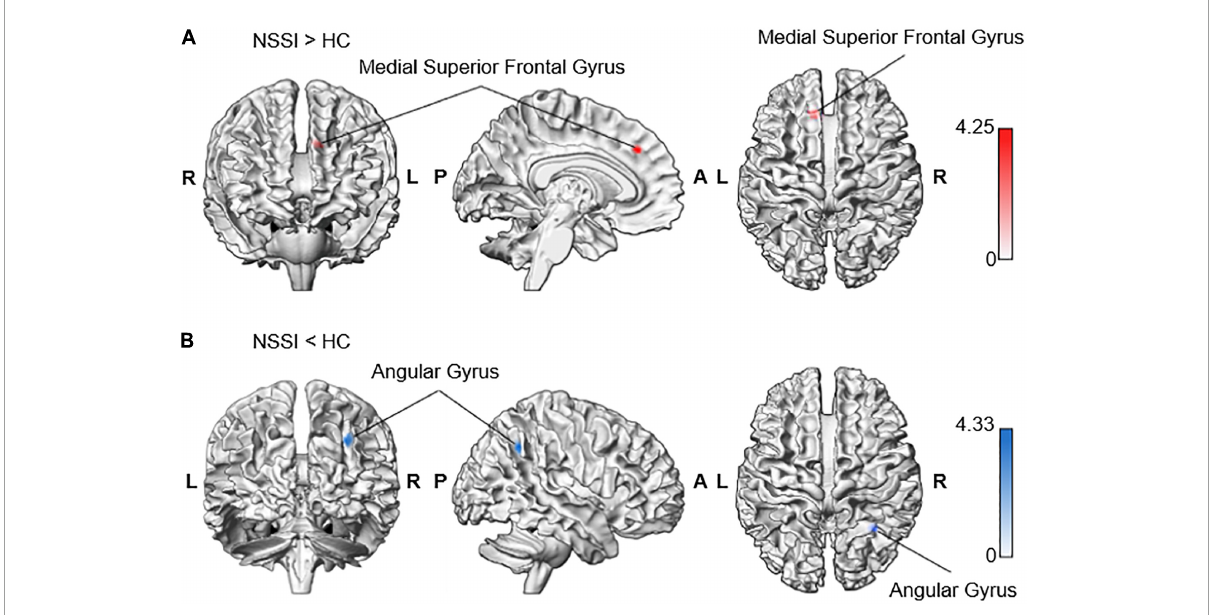
FIGURE2 Increased neural response to RMET minus control condition contrasting NSSI and control groups. The whole-brain analysis indicated increased activation during RMET in (A) the left medial superior frontal gyrus in the NSSI group ( − 10, 32, 36; Z = 3.98) and (B) the right angular gyrus in the control group (32, − 54, 40; Z = 4.04). Significant clusters were visualized using the xjView toolbox (https://www.alivelearn.net/xjview) with